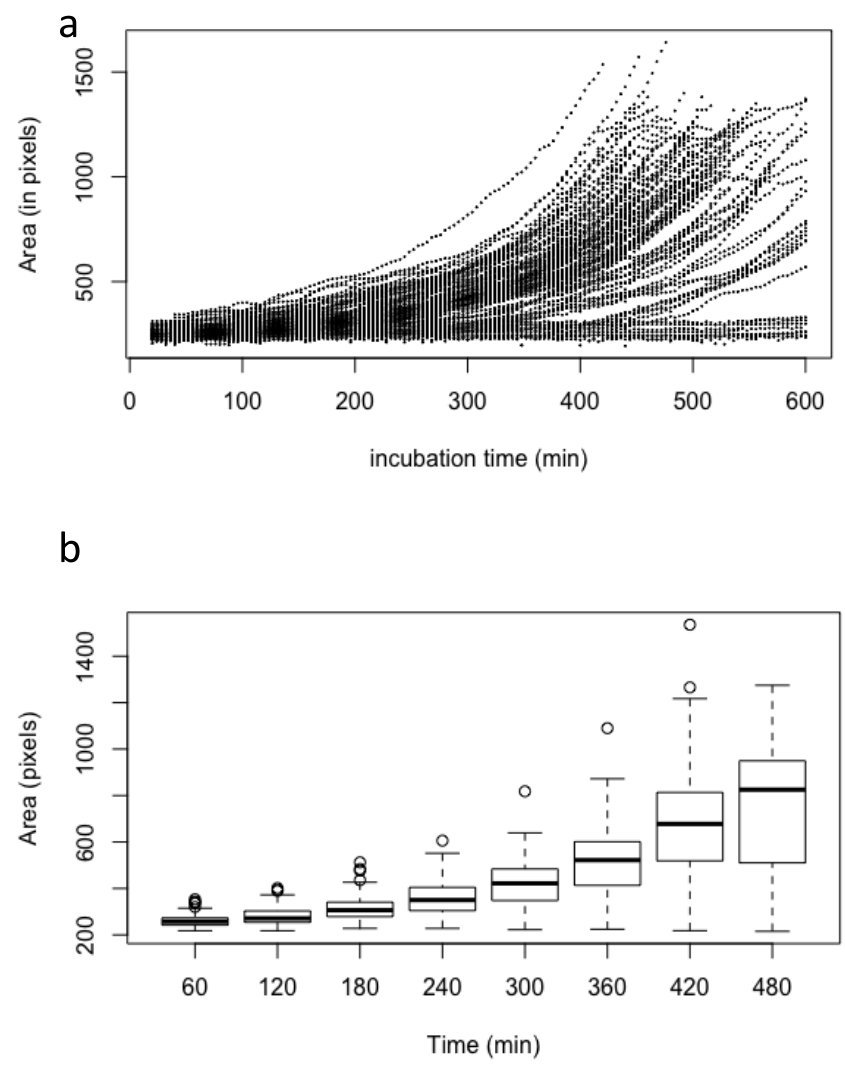
Figure 2. Asynchrony of conidial germination estimated by the measurement of the conidial volume of 100 conidia after incubation in the MM medium; ( a ) scatter plot of the volume of each conidia measured every 4 min; ( b ) box plot of the volume of all conidia measured every 60 min. Volume (estimated as pixels) was measured only on conidia without germ